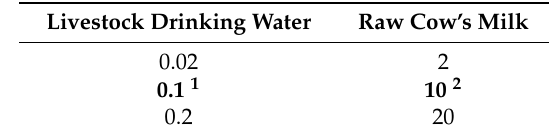
Table 1. Simazine concentrations tested (in µ g/L or ppb). The EU legal limits for simazine residue in water and milk are indicated in